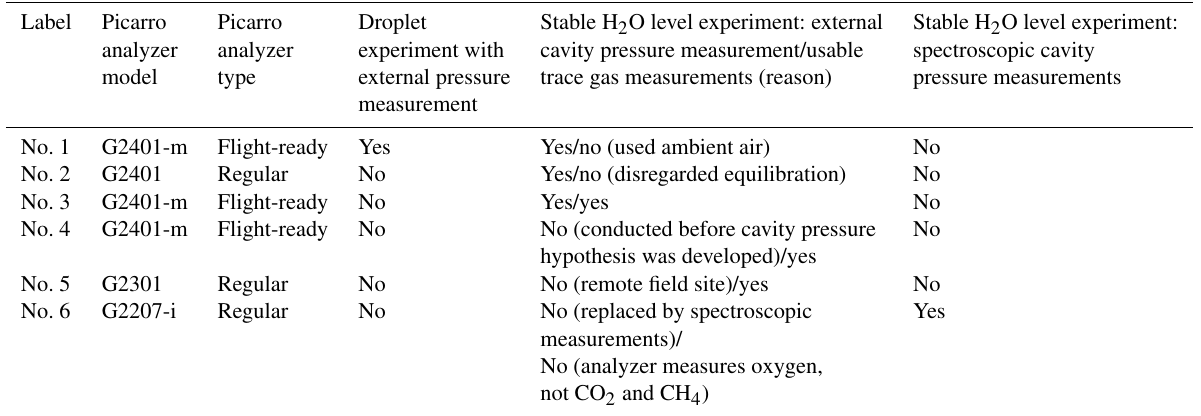
Table 1. Overview of experiments performed for this study. Experiments with Picarro nos. 1 and 2 were conducted at an early stage of this work and were designed to solely characterize the cavity pressure dependence on water vapor. Therefore, the experiments with stable H 2 O levels with these analyzers did not yield trace gas readings suitable for analysis (column 5). Experiments with Picarro nos. 4 and 5 were performed without independent pressure monitoring for reasons stated below. Spectroscopic cavity pressure measurements were not possible with Picarro GHG analyzers (see Sect.